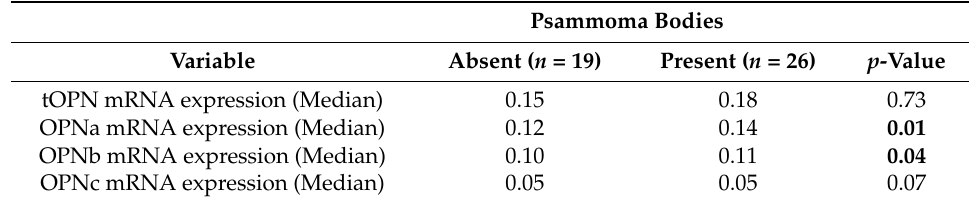
Table 2. Association between tOPN and OPN- spliced variant (OPN-SV) transcript expression levels with the presence of PB in cPTC